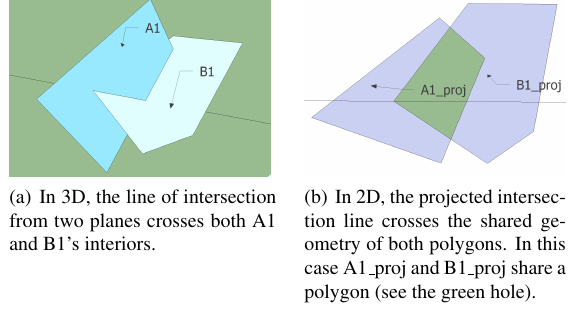
Figure 5: Overlapping polygons in 3D, their projections in 2D and the line of intersection. The hollow in 2D is the shared ge- ometry.